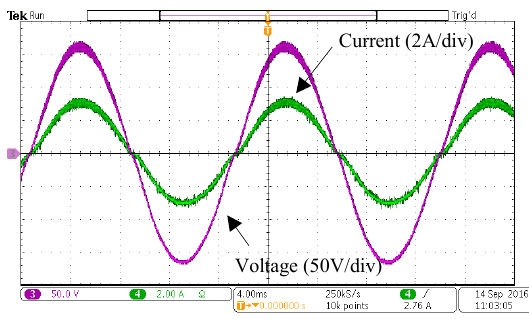
Fig. 13. Output voltage and output current when L g = 19.5 mH (without PI)